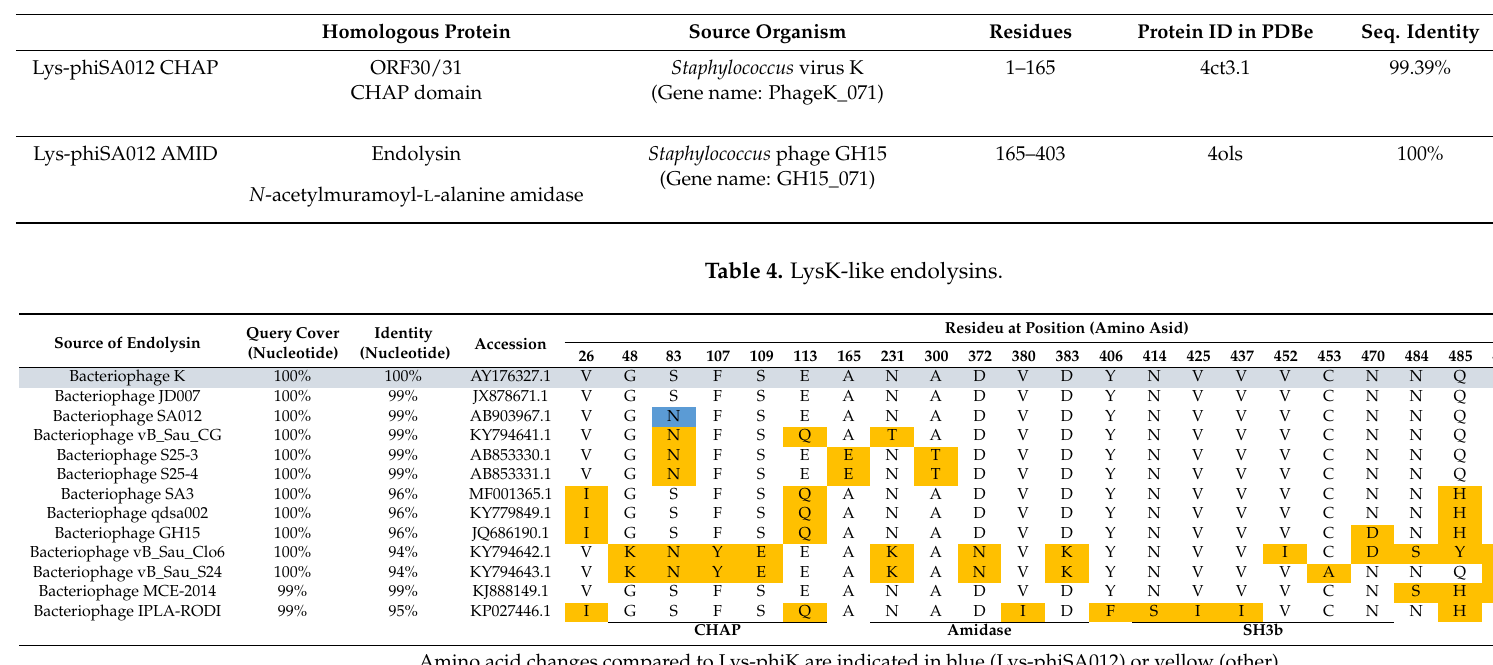
Table 3. Protein structure modeling information.